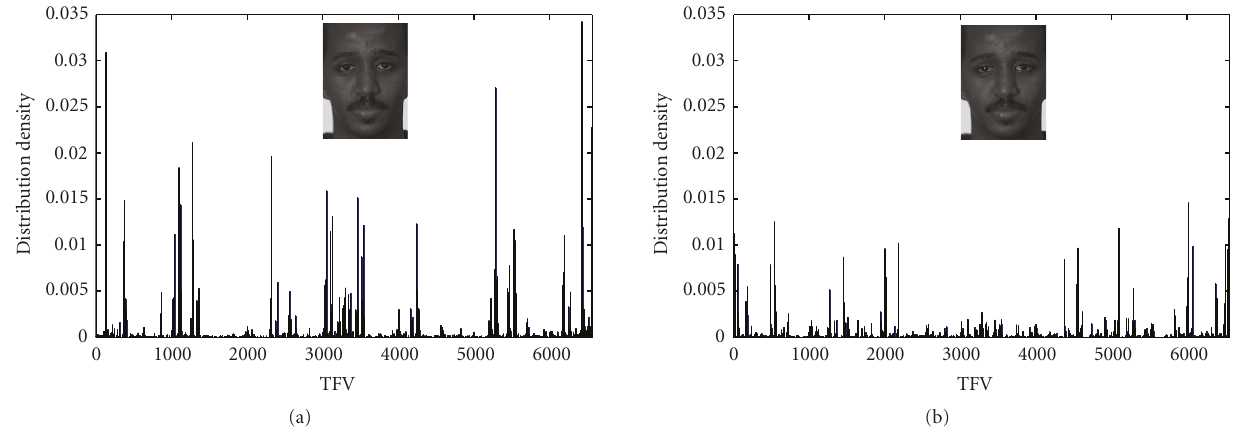
Figure 3: (a) TFV histogram of 0th coe ffi cient; (b) TFV histogram of 4th coe ffi cient. The x -axis shows di ff erent TFV vectors. The y -axis shows their corresponding probability